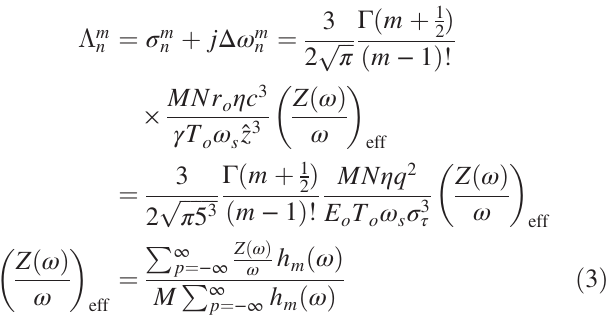
FIG. 8. Plot of H m ð ω Þ with ð ω Þ , for p from 1 to 20 for σ ¼ 250 ps. τ